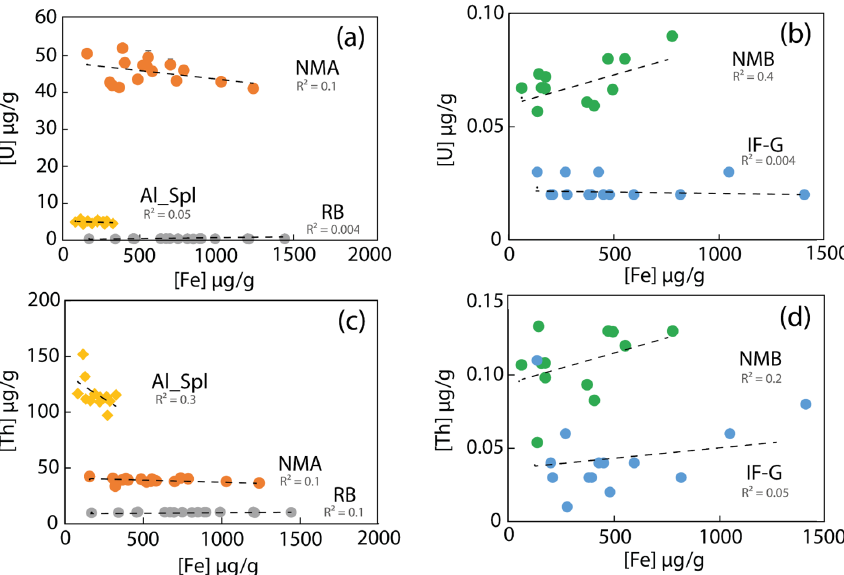
Figure 6. U and Th concentrations as a function of iron concentration in the analyzed solution. (a) NMA, Al-Spl, and RB and (b) NMB and IF-G samples. (c) NMA and Al-Spl and (d) NMB and IF-G samples.